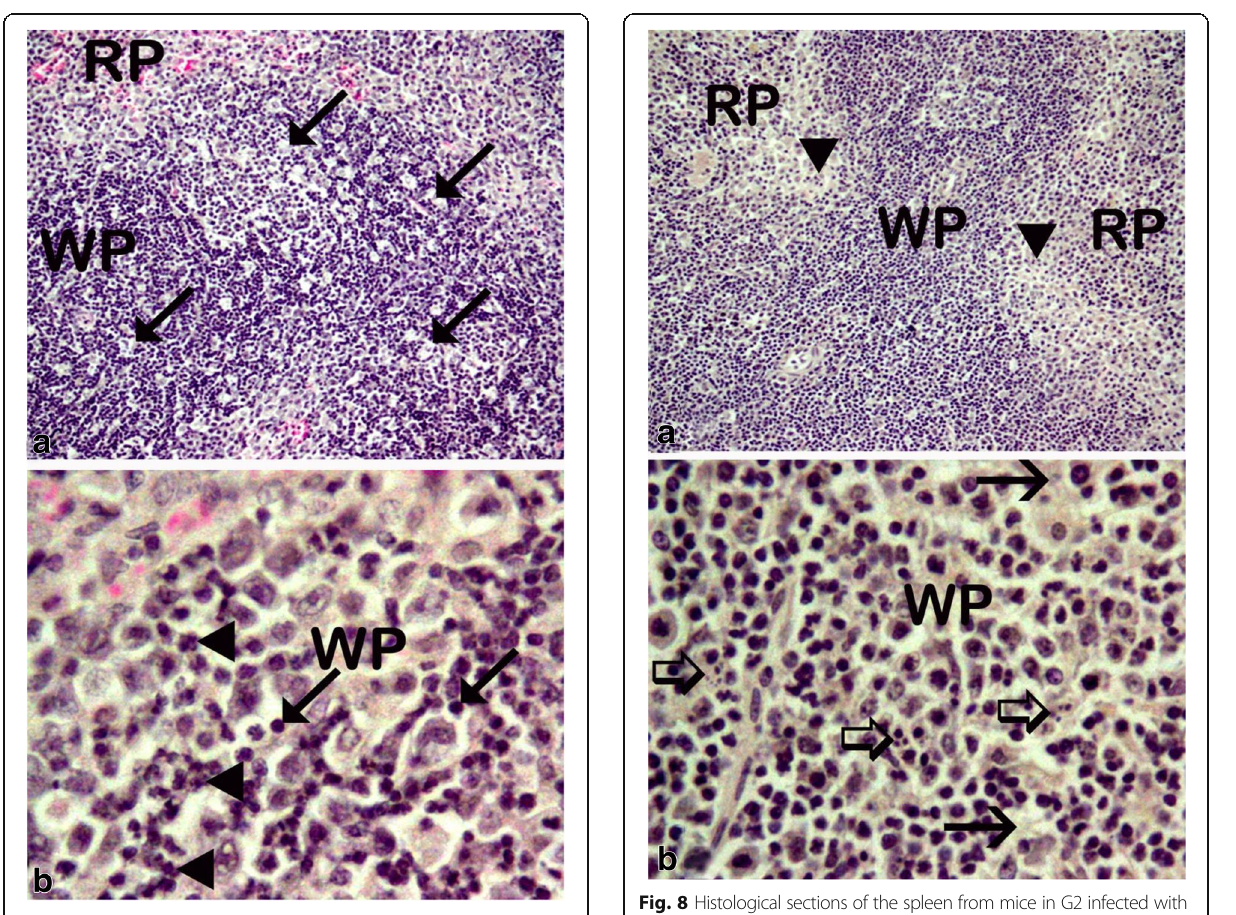
Fig. 7 Histological sections of the spleen from mice in G1 infected with T. congolense and treated with 1500 mg/kg of C. swynnertonii extracts, 8 hourly intervals but died on third day of treatment. There are white foci of variable sizes in the white pulp ( black arrows ) in ( a ). Pyknosis ( black arrows) and karyorrhexis ( arrow head ) of lymphocytes are evident in ( b ). Magnifications, ( a ) 100 x; ( b ) 1000